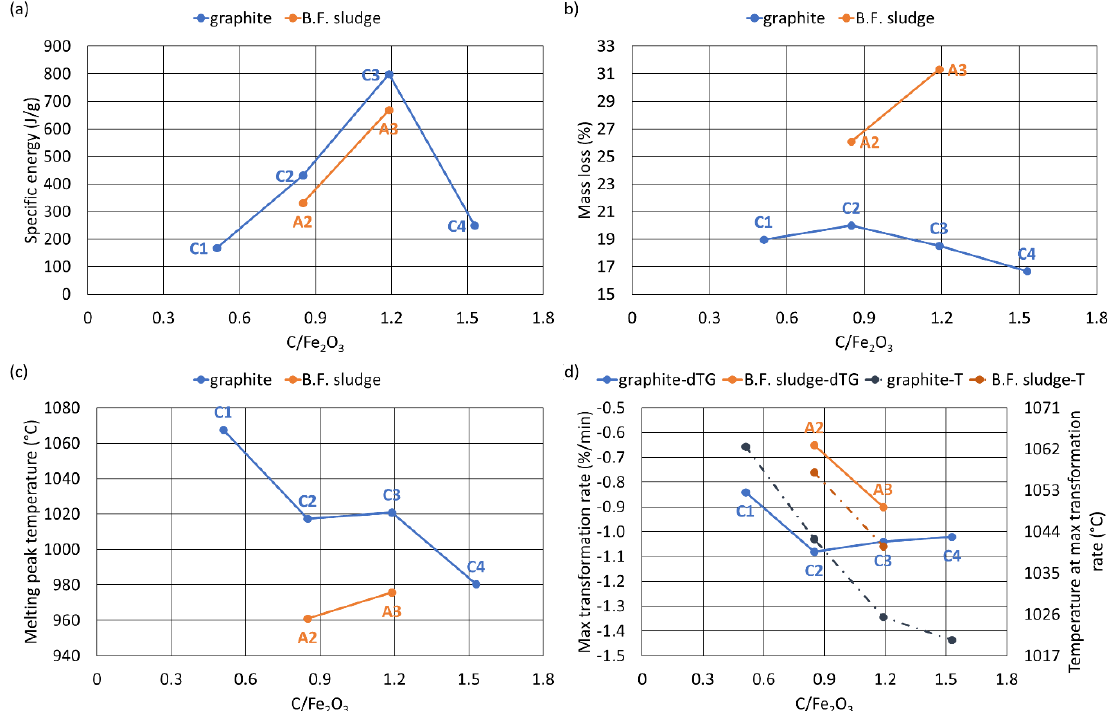
Figure 2. Specific energy of the cast iron melting peak ( a ), total mass loss ( b ), temperature of the iron melting, ( c ) and transformation rate parameters ( d ) as a function of C / Fe 2 O 3 ratio. Argon atmosphere. TG-DSC results show different behaviour in samples with graphite and B.F. sludges. Increasing